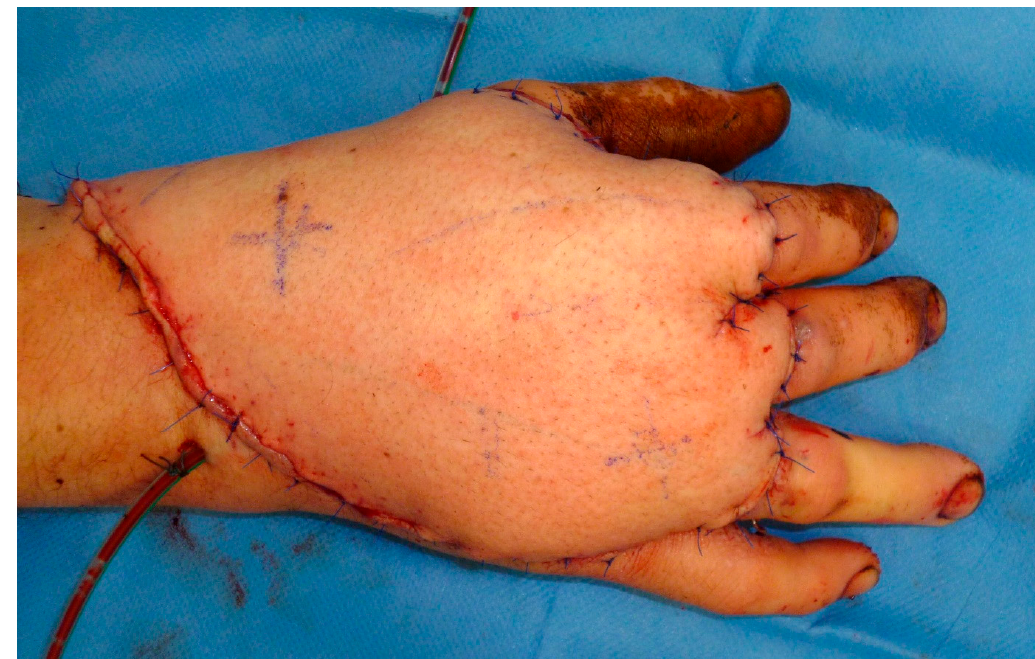
Figure 7. Defect after burn wound debridement of a full-thickness burn to the hand. Necrotic extensor tendons and ne- crotic capsules of metacarpal joints were resected.